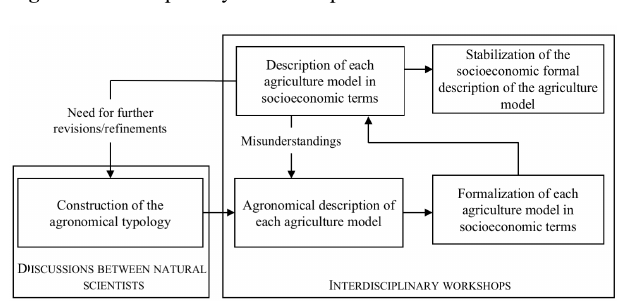
Fig. 1 . Interdisciplinary feedback